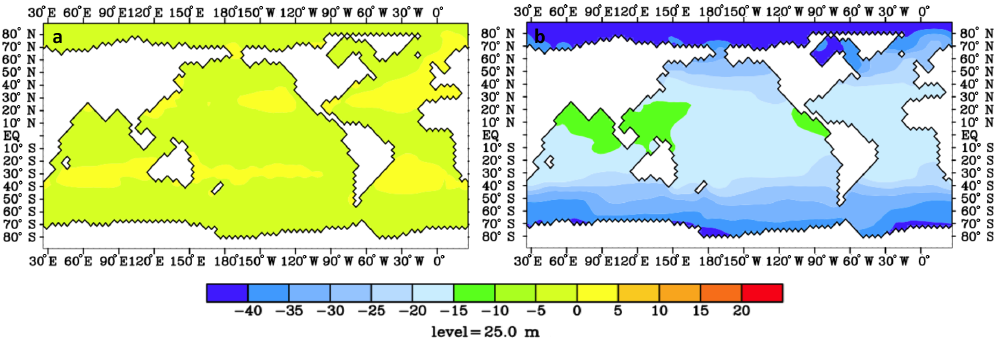
Figure 5. Dissolved O 2 concentration simulated by (a) the 4 × CO 2 experiment without CO 2 radiative forcing minus the reference experi- ment and (b) the 4 × CO 2 with CO 2 radiative forcing simulation minus the reference experiment.